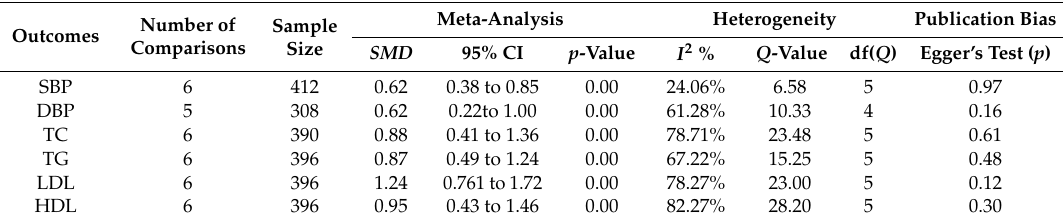
Table 3. Synthesized results for the e ff ects of Wuqinxi versus